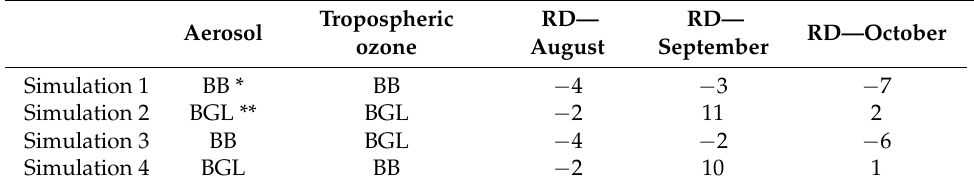
Table 1. Relative differences (%) between modelled and observed UVI from Tropospheric Ultraviolet- Visible (TUV) model simulations with and without aerosols and tropospheric ozone for August to October (2011 to 2017) and the average relative difference between August and October (ASO). Tropospheric RD— RD— Aerosol ozone August September